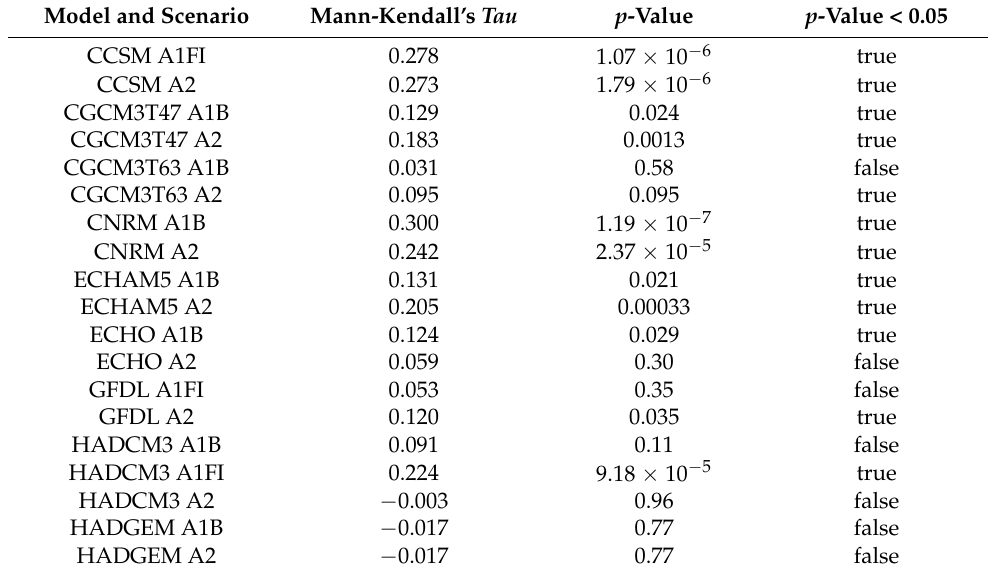
Table 3. Parameters obtained after a Mann-Kendall test with alpha = 0.05 for detection of trends in the projected annual peak flows in the bridge of US 151 in Cedar River at Cedar